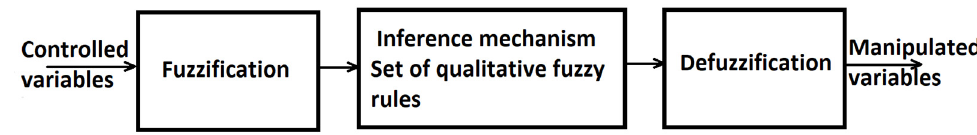
Figure 8. General structure of a fuzzy controller. Figure 8 . General structure of a fuzzy controller.